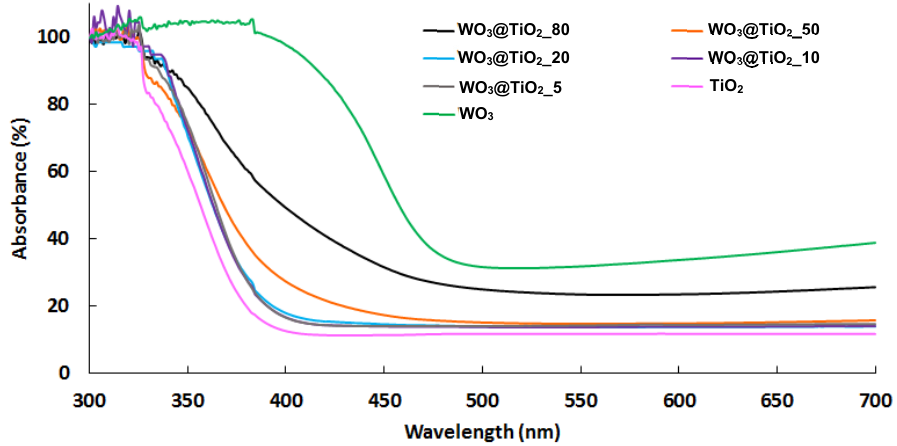
Figure 4. UV–Vis absorption spectra of the WO 3 /TiO 2 composites series calcined at 400 °C.